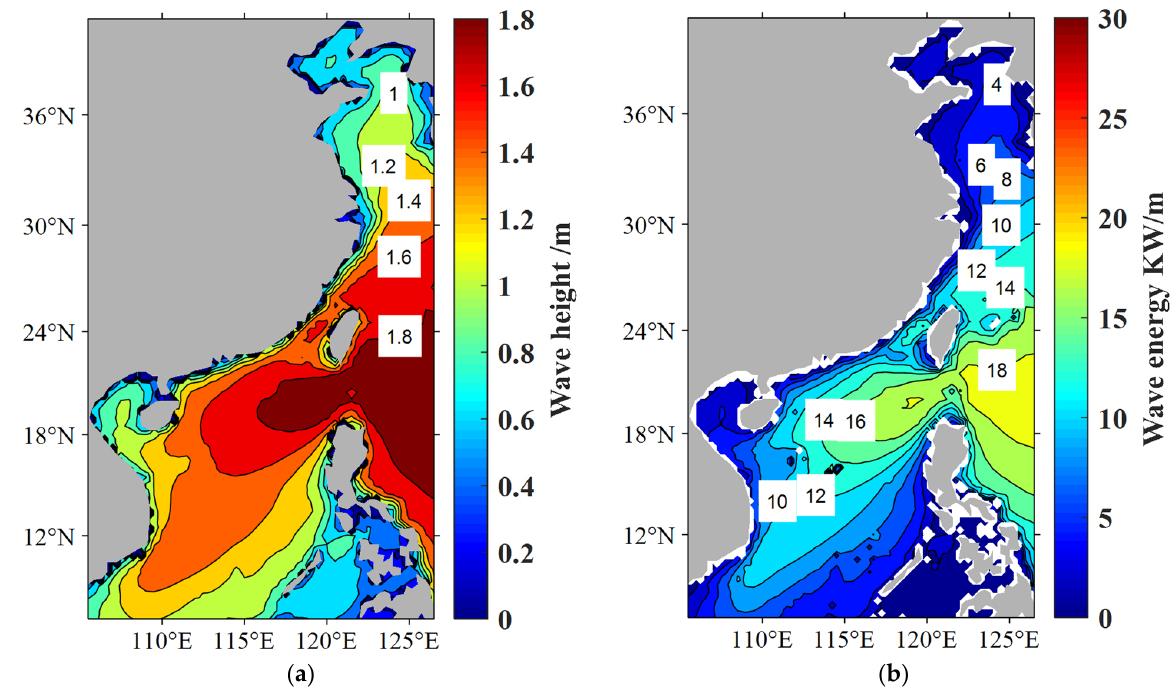
Figure 2. The annual mean significant wave height ( a ) ( H s ) and wave energy density ( b ) ( P w ).